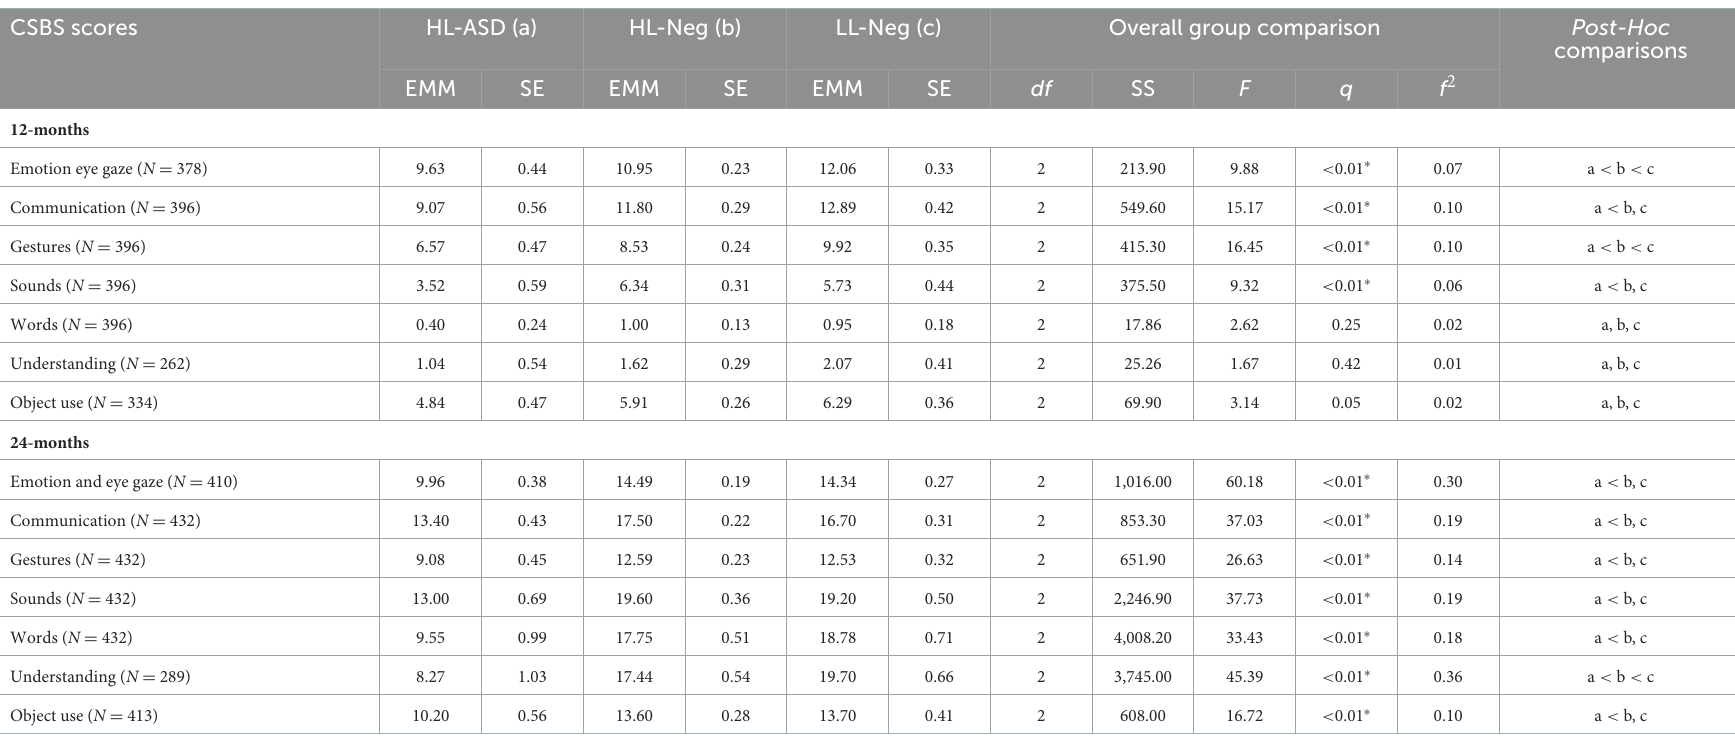
TABLE 4 Post-hoc cross-sectional analysis exploring the main effect for group. CSBS scores HL-ASD (a) HL-Neg (b) LL-Neg (c) Overall group comparison Post-Hoc